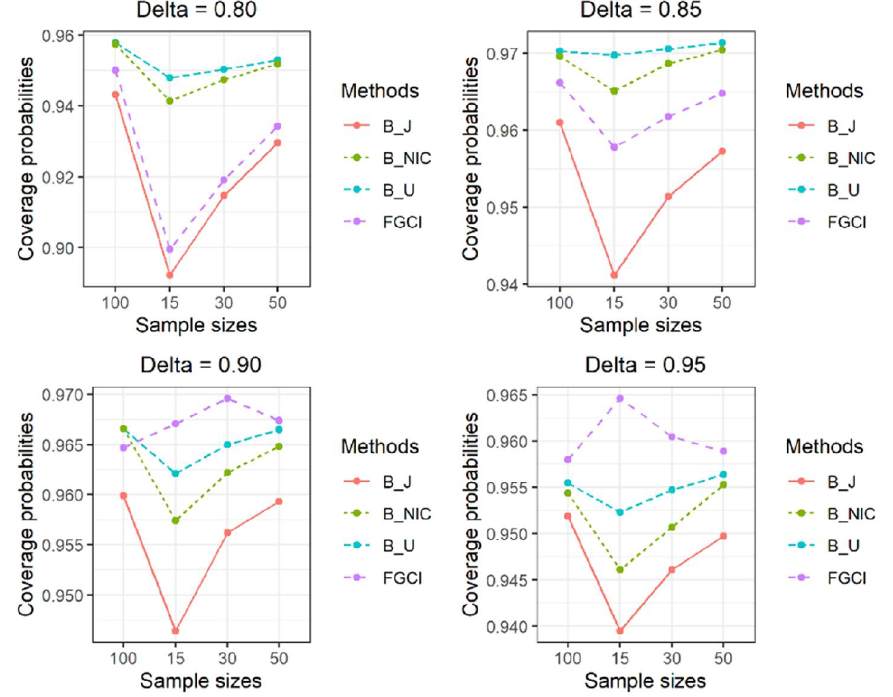
Figure 2. The coverage probabilities of the 95% confidence intervals and the credible intervals for the CQV by the probabilities of non-zero